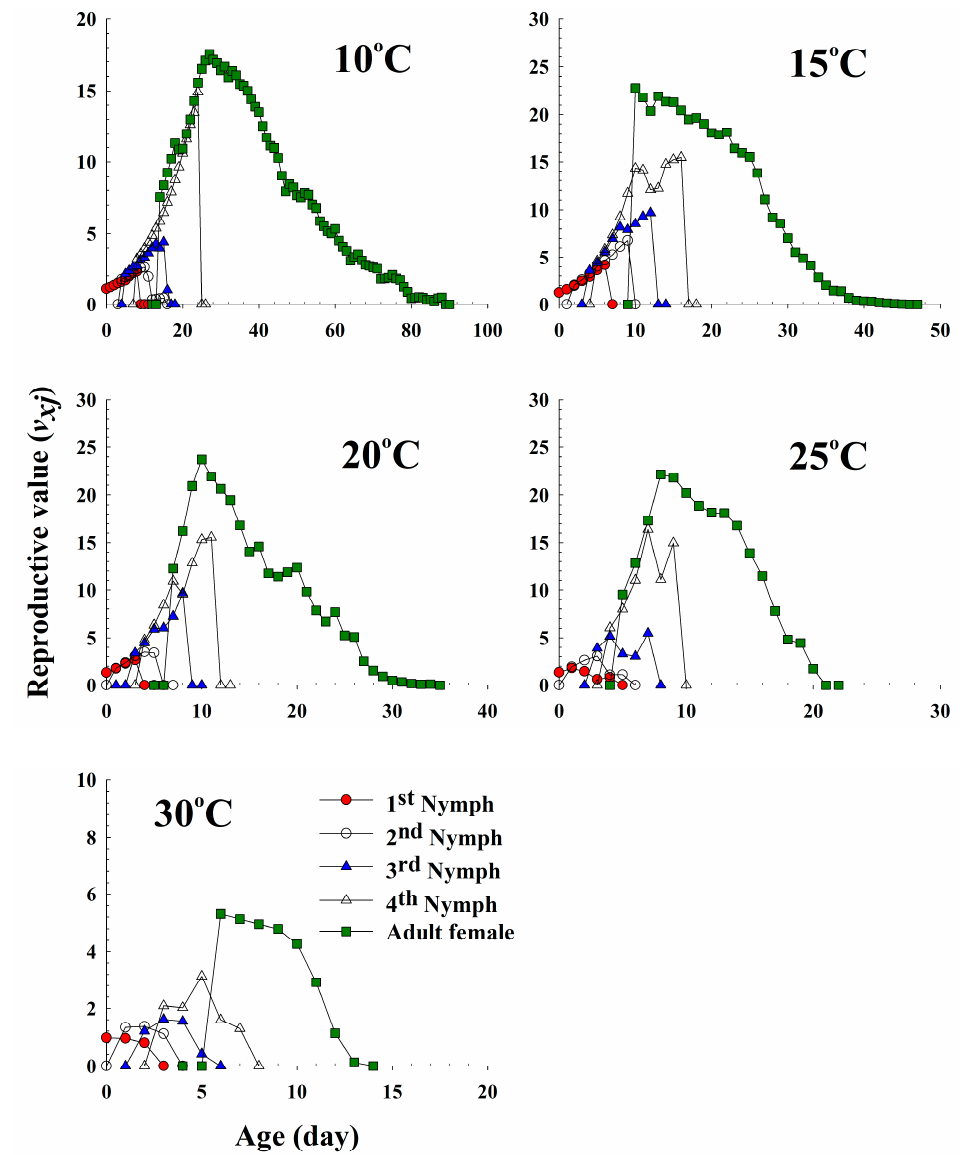
Figure 5. The age-stage-specific reproductive value ( v xj ) of Acyrthosiphon pisum in response to different temperature conditions.